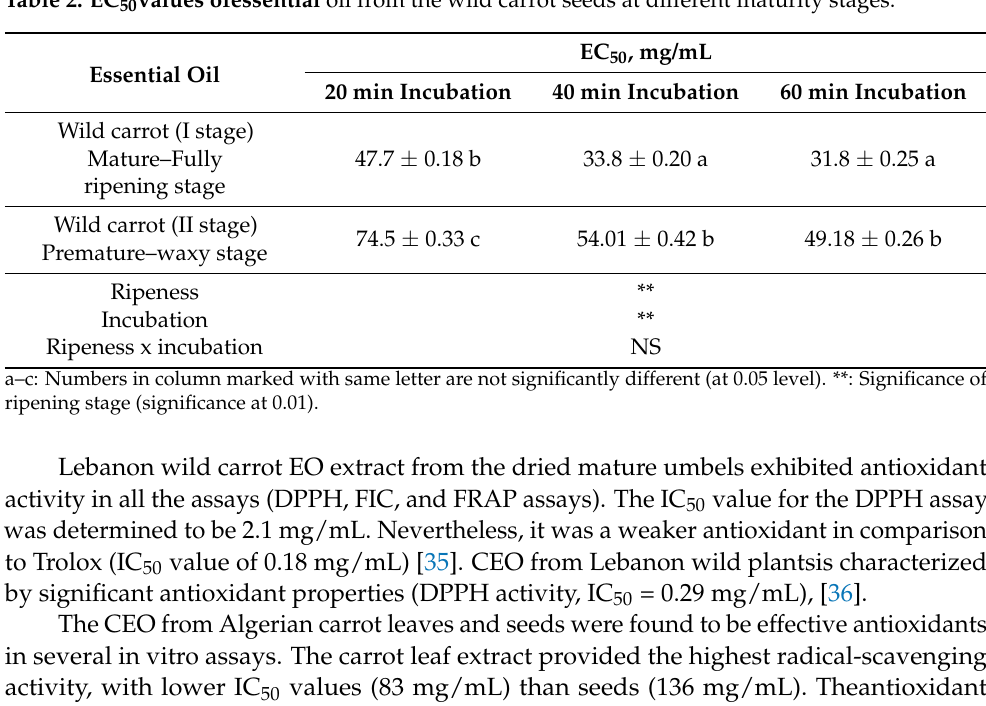
Table 2. EC 50 values ofessential oil from the wild carrot seeds at different maturity